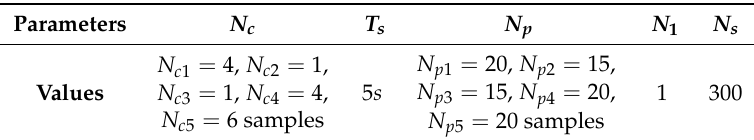
Table 2. MPC parameters.